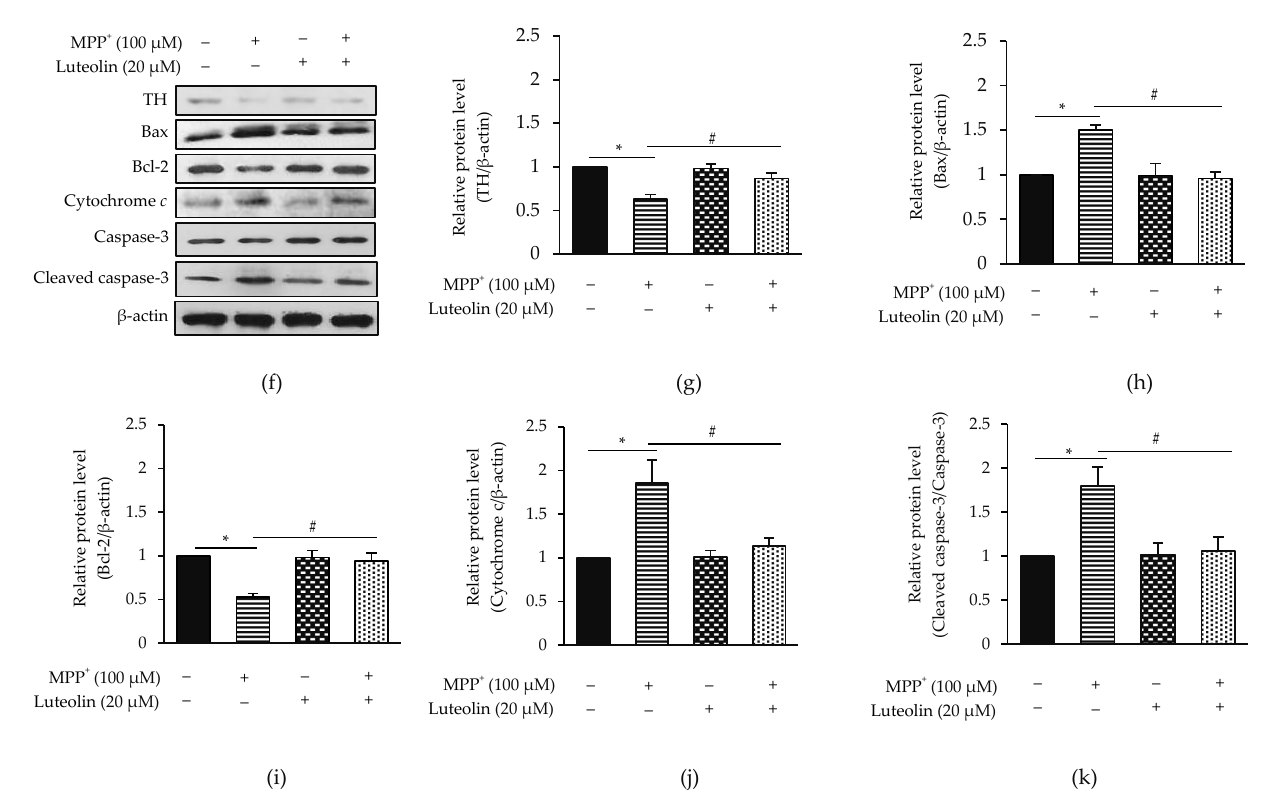
Figure 2. Luteolin alleviate MPP + -induced apoptosis in SH-SY5Y cells. Cells were pre-treated with 20 µ M luteolin for 1 h, followed by 100 µ M MPP + for 24 h. After 24 h, apoptotic cells were evaluated by Hoechst 33342 staining, Annexin V-FITC/7-ADD staining and western blotting. ( a ) Stained cells with Hoechst 33342. Nuclear condensation and nuclear fragmentation were observed under fluorescence microscope (20 × ). Bar graph represented percentage of apoptotic nuclei. ( b ) Stained cells with Annexin V-FITC/7-ADD and flow cytometry was then applied for identifying apoptotic cells. Bar graph represents the percentage of apoptotic cells. ( c , f ) Expressions of α -synuclein, TH, Bax, Bcl-2, cytochrome c, capase-3 and cleaved caspase-3 were measured by western blot analysis. Quantification of ( d , e ) α -synuclein ( g ) TH, ( h ) Bax, ( i ) Bcl-2, ( j ) cytochrome c and ( k ) cleaved caspase-3/capase-3 was shown in the bar graph. Data were normalized using β -actin as control. Results are shown as mean ± SD for triplicated independent experiments. Differences are statistically significant at * p < 0.05 versus the control group and # p < 0.05 versus the MPP + group.